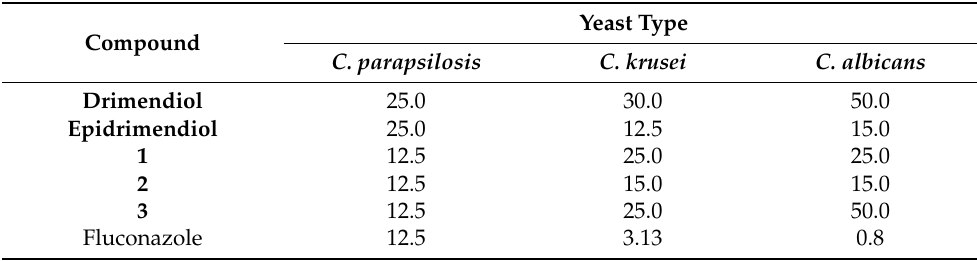
Table 4. The minimum inhibitory and fungicidal concentration values (MIC µ g/mL) of drimendiol, epidrimendiol and the biotransformation products 1 to 3 .